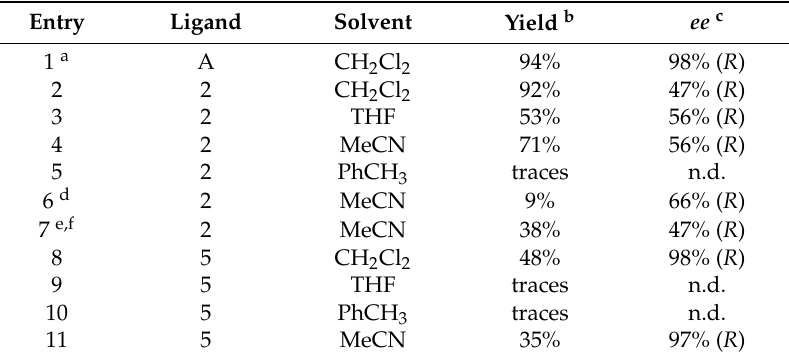
Table 2. Pd-catalyzed allylic alkylation of rac - 7 using ligands 2 and 5 . Entry